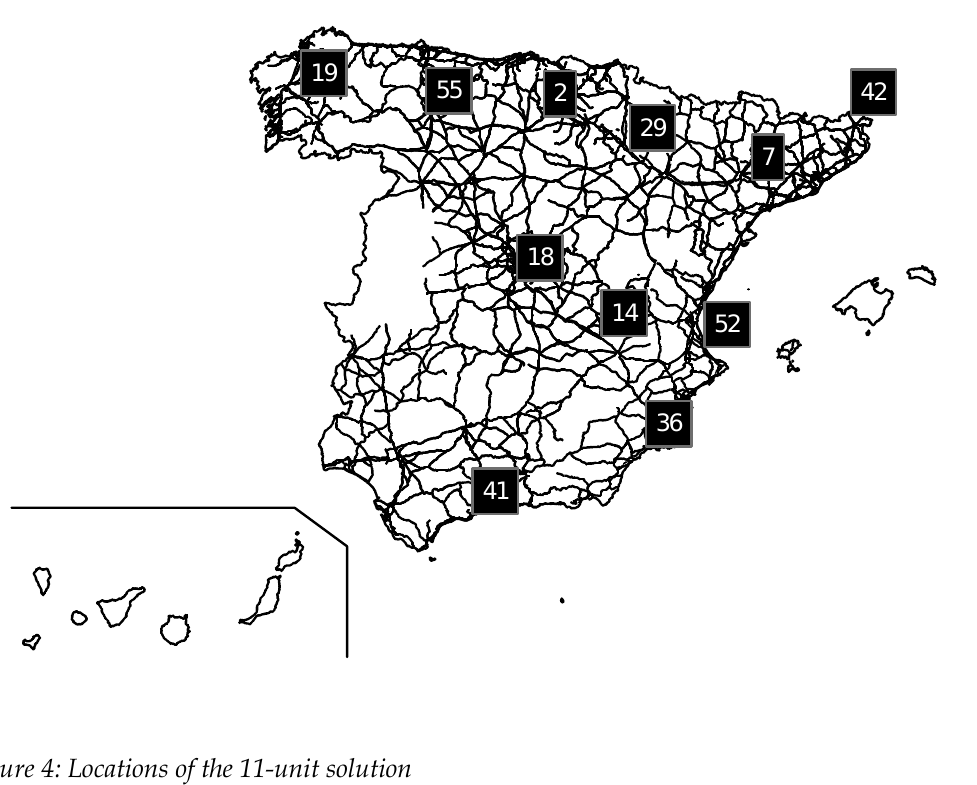
Figure 4: Locations of the 11-unit